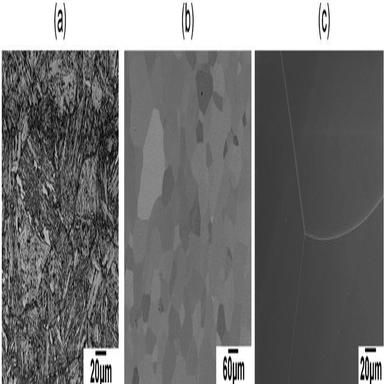
SEM micrographs of (a) split-melt steel, (b) Ti alloy, and (c) multicrystalline silicon samples.